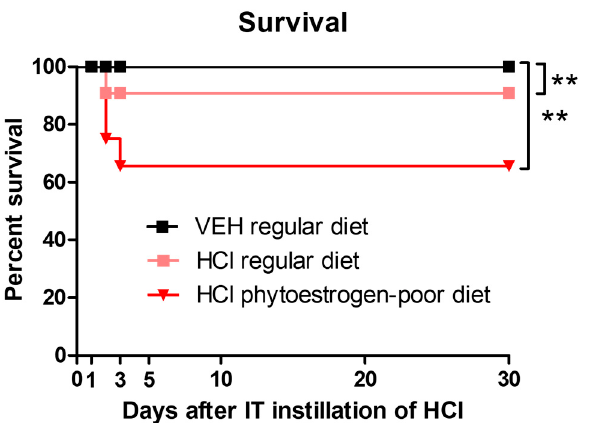
Figure 1. Mice on normal diet are more resistant to HCl-induced mortality. Kaplan–Meyer survival curves. Means ± SEM; **: p < 0.01, with ANOVA and Tukey’s, n = 6–8; VEH: Vehicle. 3.2. Dietary Phytoestrogens Reduce HCl-Induced Chronic Alveolar Inflammation Animals instilled with vehicle showed no signs of alveolar inflammation (Figure 2A). Mice on regular diet and instilled with HCl demonstrated thickening of alveolar walls, infiltration of alveolar and interstitial mononuclear cells (black arrows), and massive formation of hyaline membranes (blue arrows) in the alveolar space.